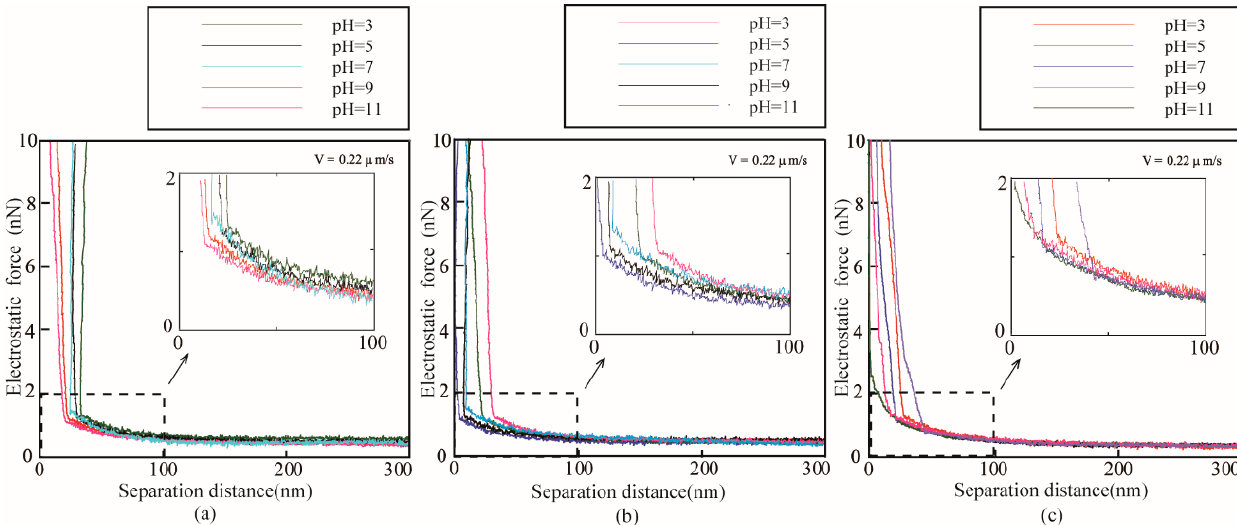
Figure 6. Electrostatic force of ( a ) superoleophilic, ( b ) oleophobic, and ( c ) superoleophobic surfaces immersed in DI water with different pH value obtained at a sphere velocity of 0.22 μ m/s.